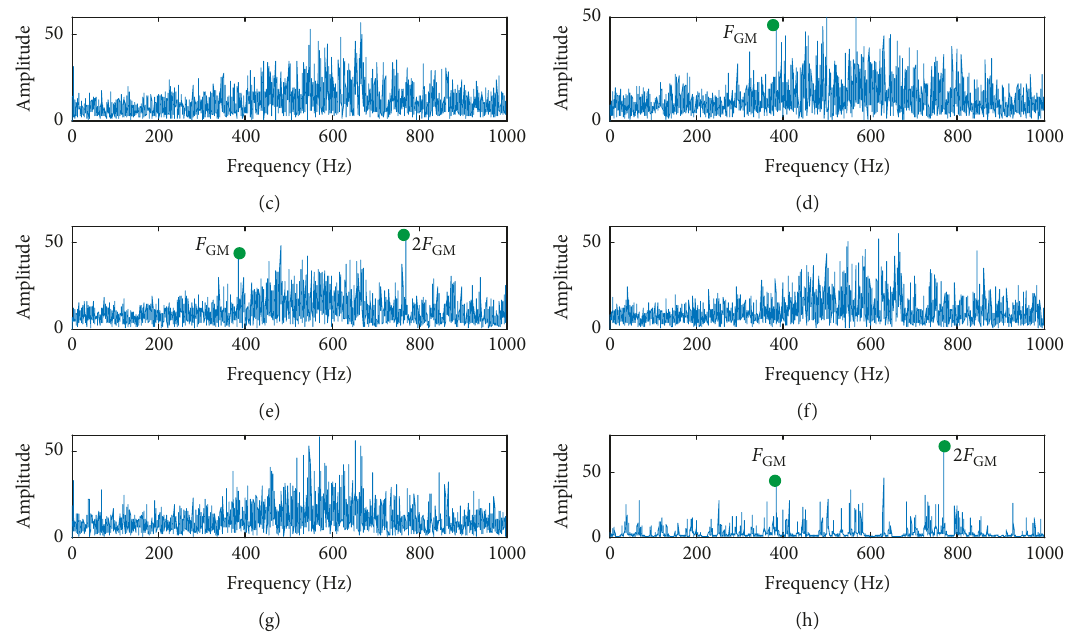
Figure 33: The Frequency domain diagram of multiresolution DMD modes of the pitch errors signal, where (a)–(h) are corresponding to signals in Figure 29, respectively.